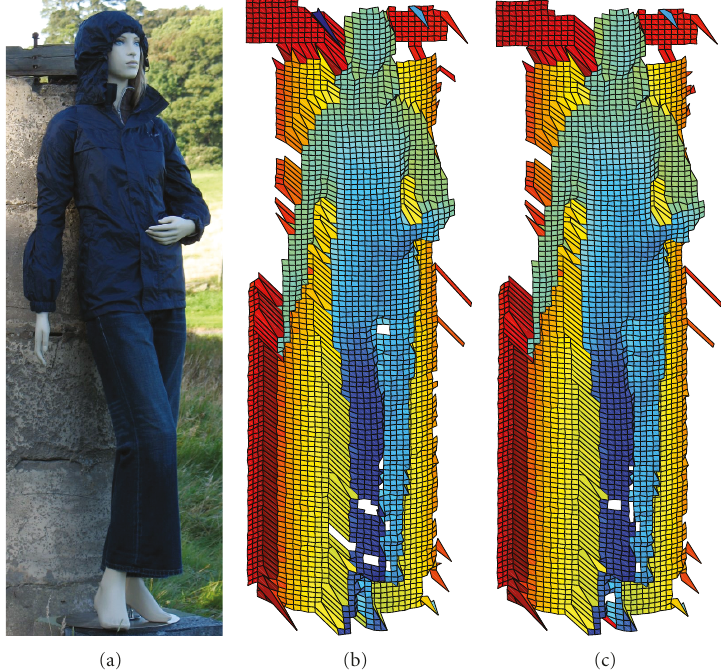
Figure 5: 32 × 128 pixel image of a life-sized mannequin scanned at a distance of 325 m in daylight conditions. (a) Photograph of the 1.8 m tall mannequin in the scan position. (b) and (c) Three-dimensional plots of the processed depth information using the cross-correlation and MCMC methods, respectively. Empty pixels in the plots contained depth values outside the displayed range. The lower number of missing pixels in (c) on noncooperative target surfaces with low reflectance, especially the mannequin’s trousers, demonstrate the MCMC algorithm’s advantage in resolving low-intensity